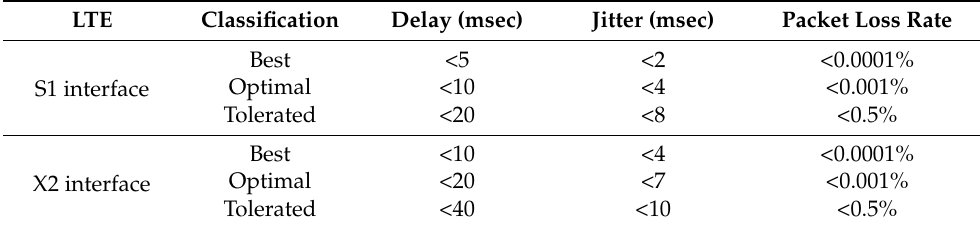
Table 1. Normalized delay, jitter, and packet loss rate.